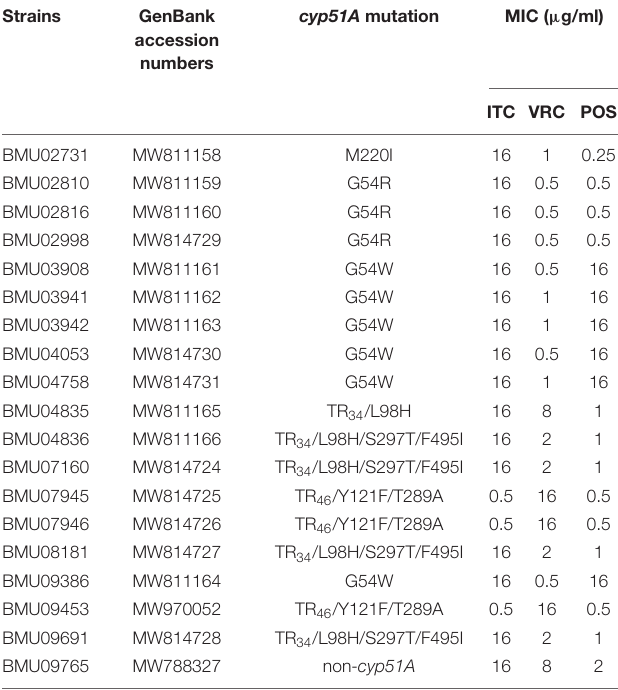
TABLE 4 | Cyp51A mutations of non-WT A. fumigatus isolates.